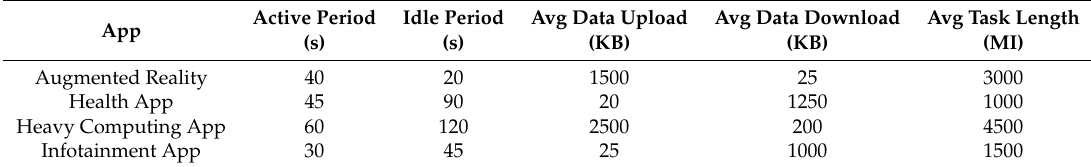
Table 2. Applications